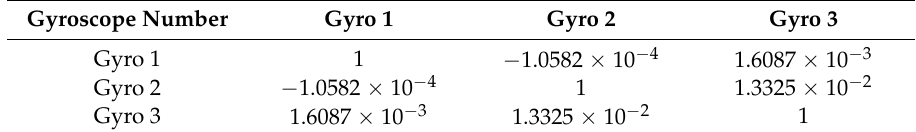
Table 2. The correlation coefficients between each gyroscopes.